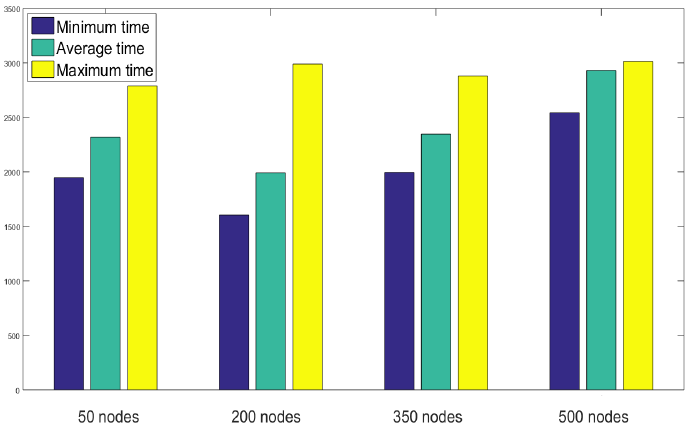
Figure 11. Performance analysis based on sensor record reading